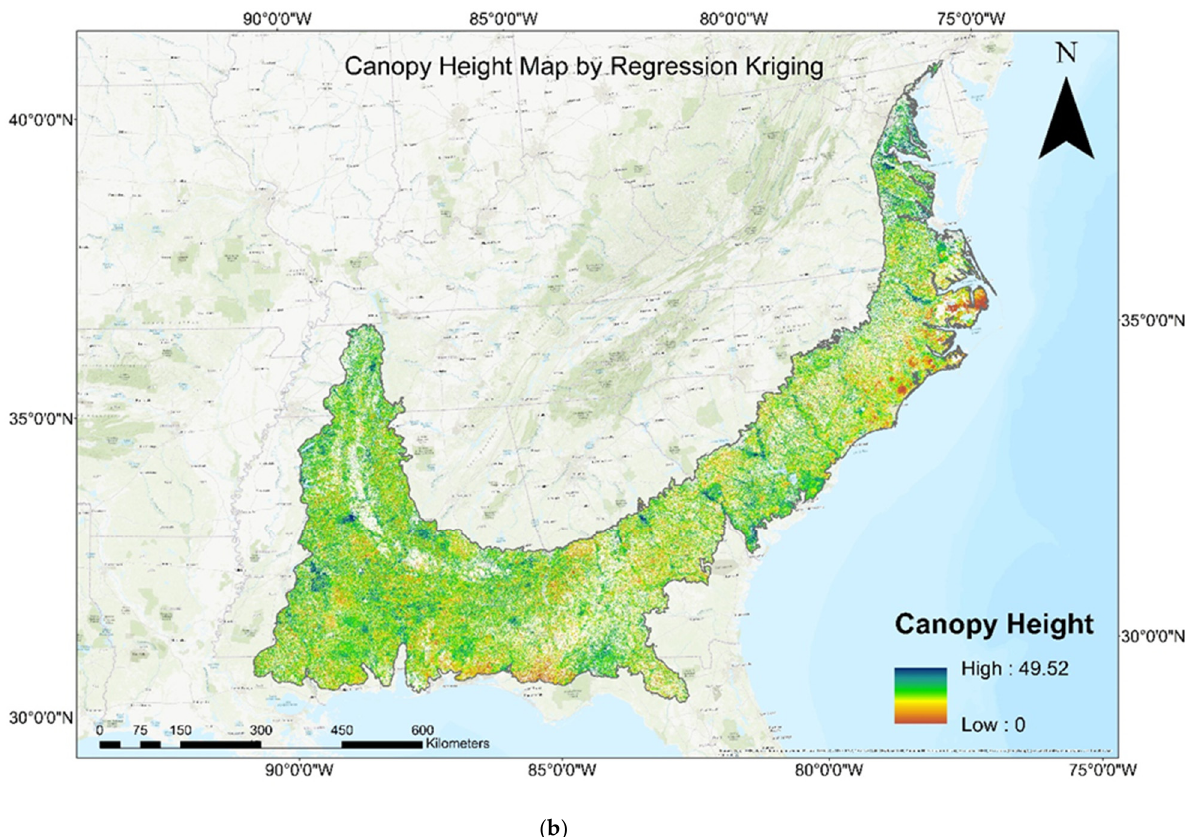
Figure 4. Canopy height maps at 30 m spatial resolution estimated by ( a ) random forest and ( b ) regression kriging.